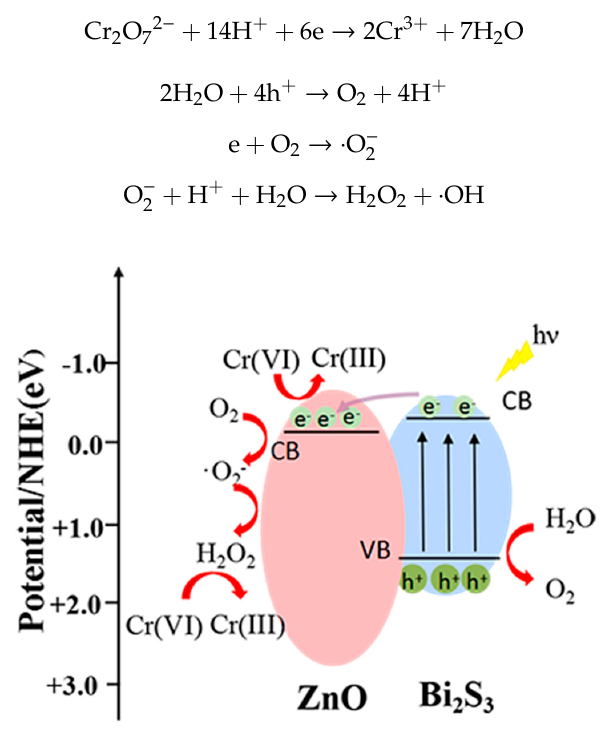
Figure 10. Schematic mechanism illustration of photoinduced electron-hole separation and transfer within ZnO / Bi 2 S 3 composites for visible light-driven photoreduction of aqueous Cr(VI).